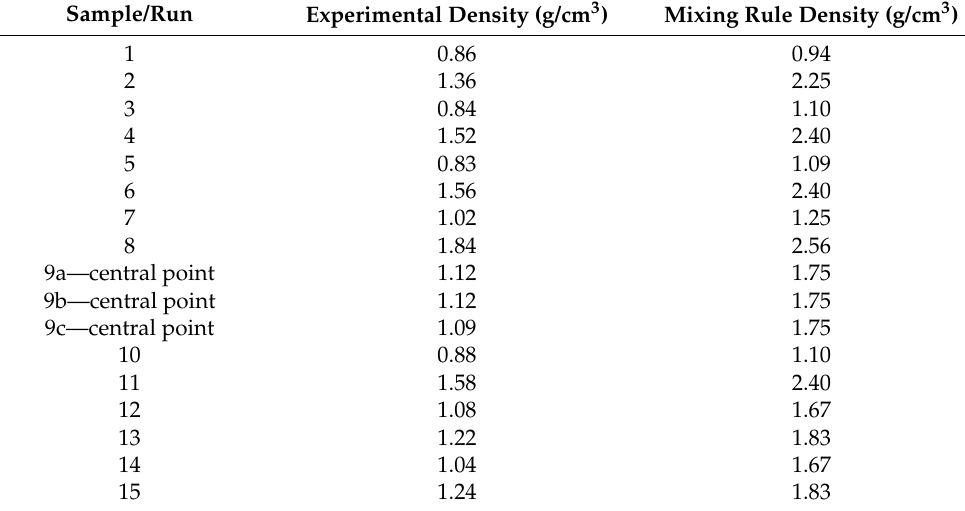
Table 5. Density results of the prepared composites in combination with the density according to the mixing